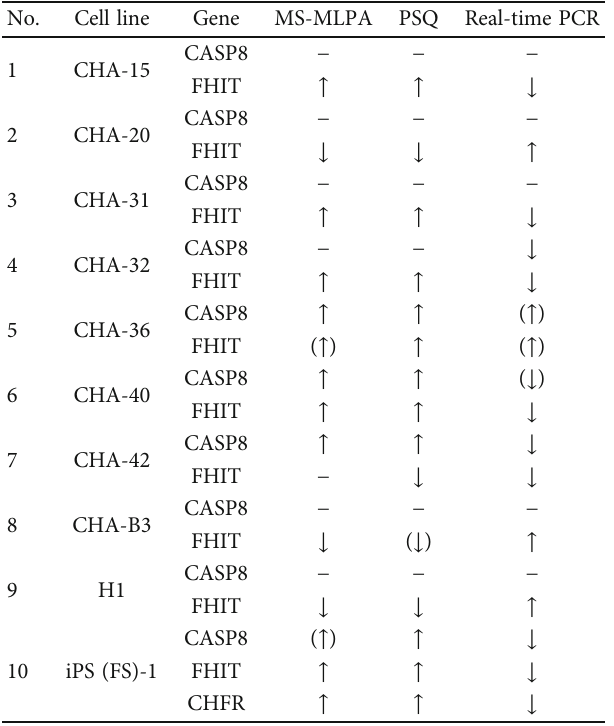
Table 1: Comparison of MS-MLPA, pyrosequencing, and real-time PCR